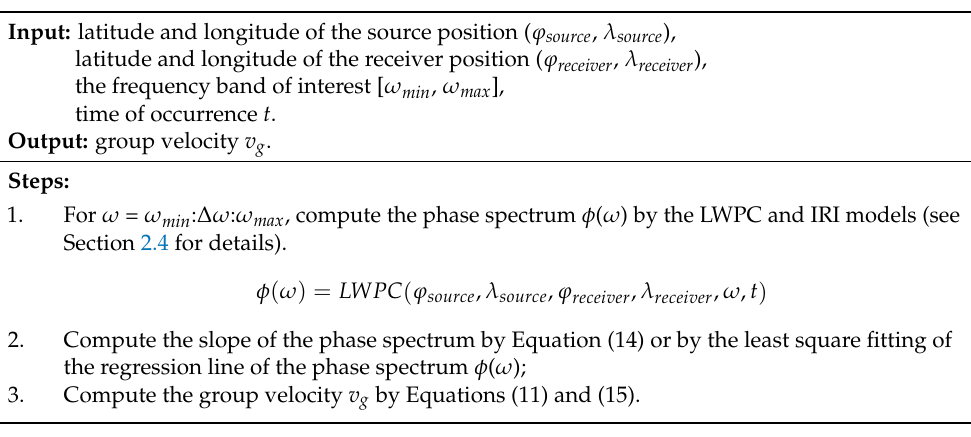
Table 1. The computational procedure of the proposed group velocity estimation